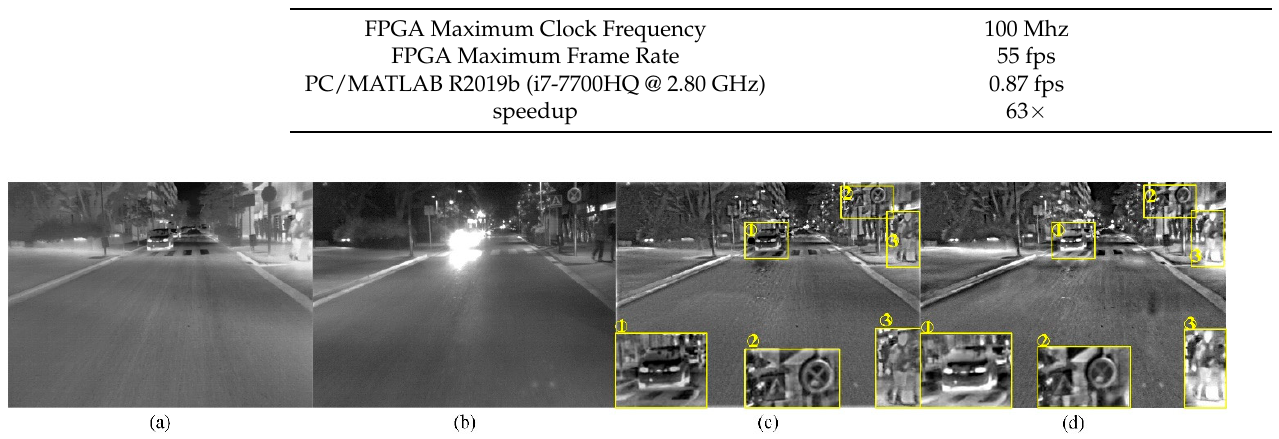
Table 4. Speed performance compared to PC implementation.